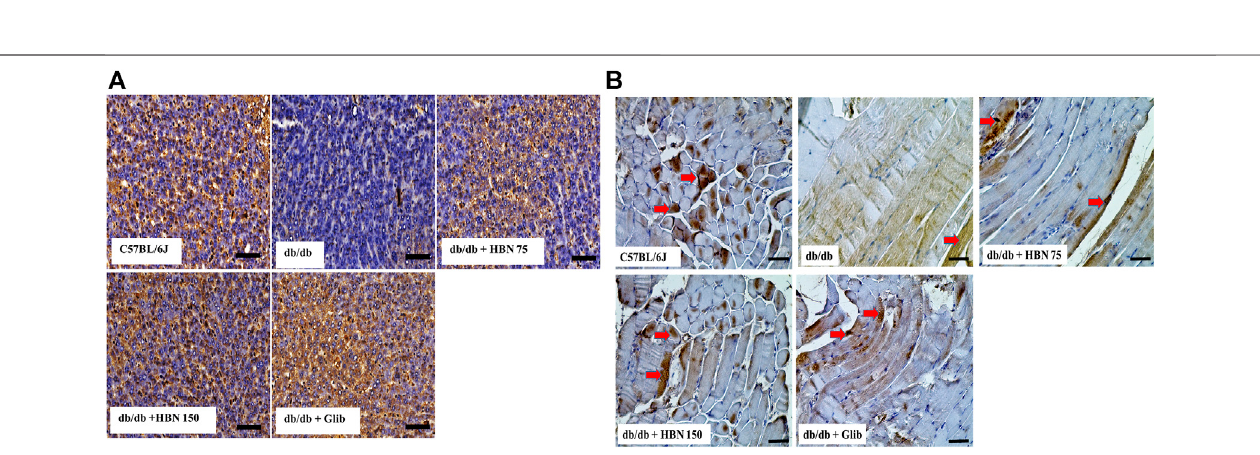
FIGURE 8 | Effects of HBN on glucose transporter 4 (GLUT-4) level. Representative immunoperoxidase images showing GLUT-4 distribution in the liver (A) and skeletal muscle (B) . The sites of distribution are indicated by dark brown staining. Scale bar (cid:2) 100 μ m. Magni fi cation × 40.